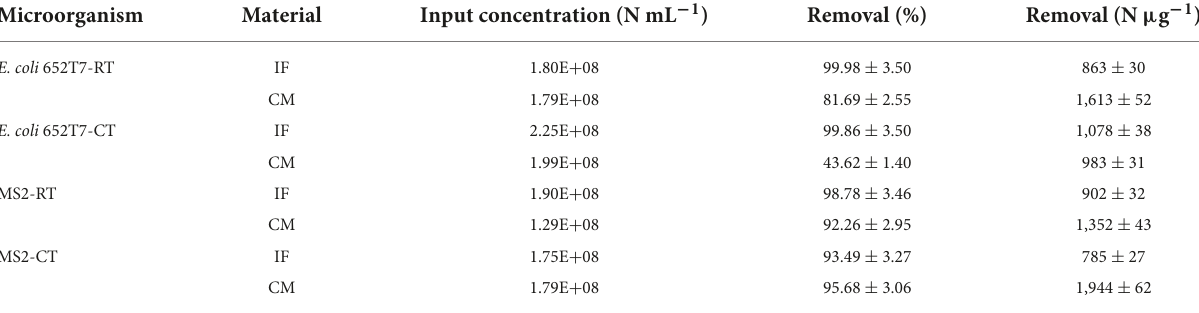
TABLE 4 Removal of microorganisms in respective transport (RT) and co-transport (CT) experiments. Microorganism